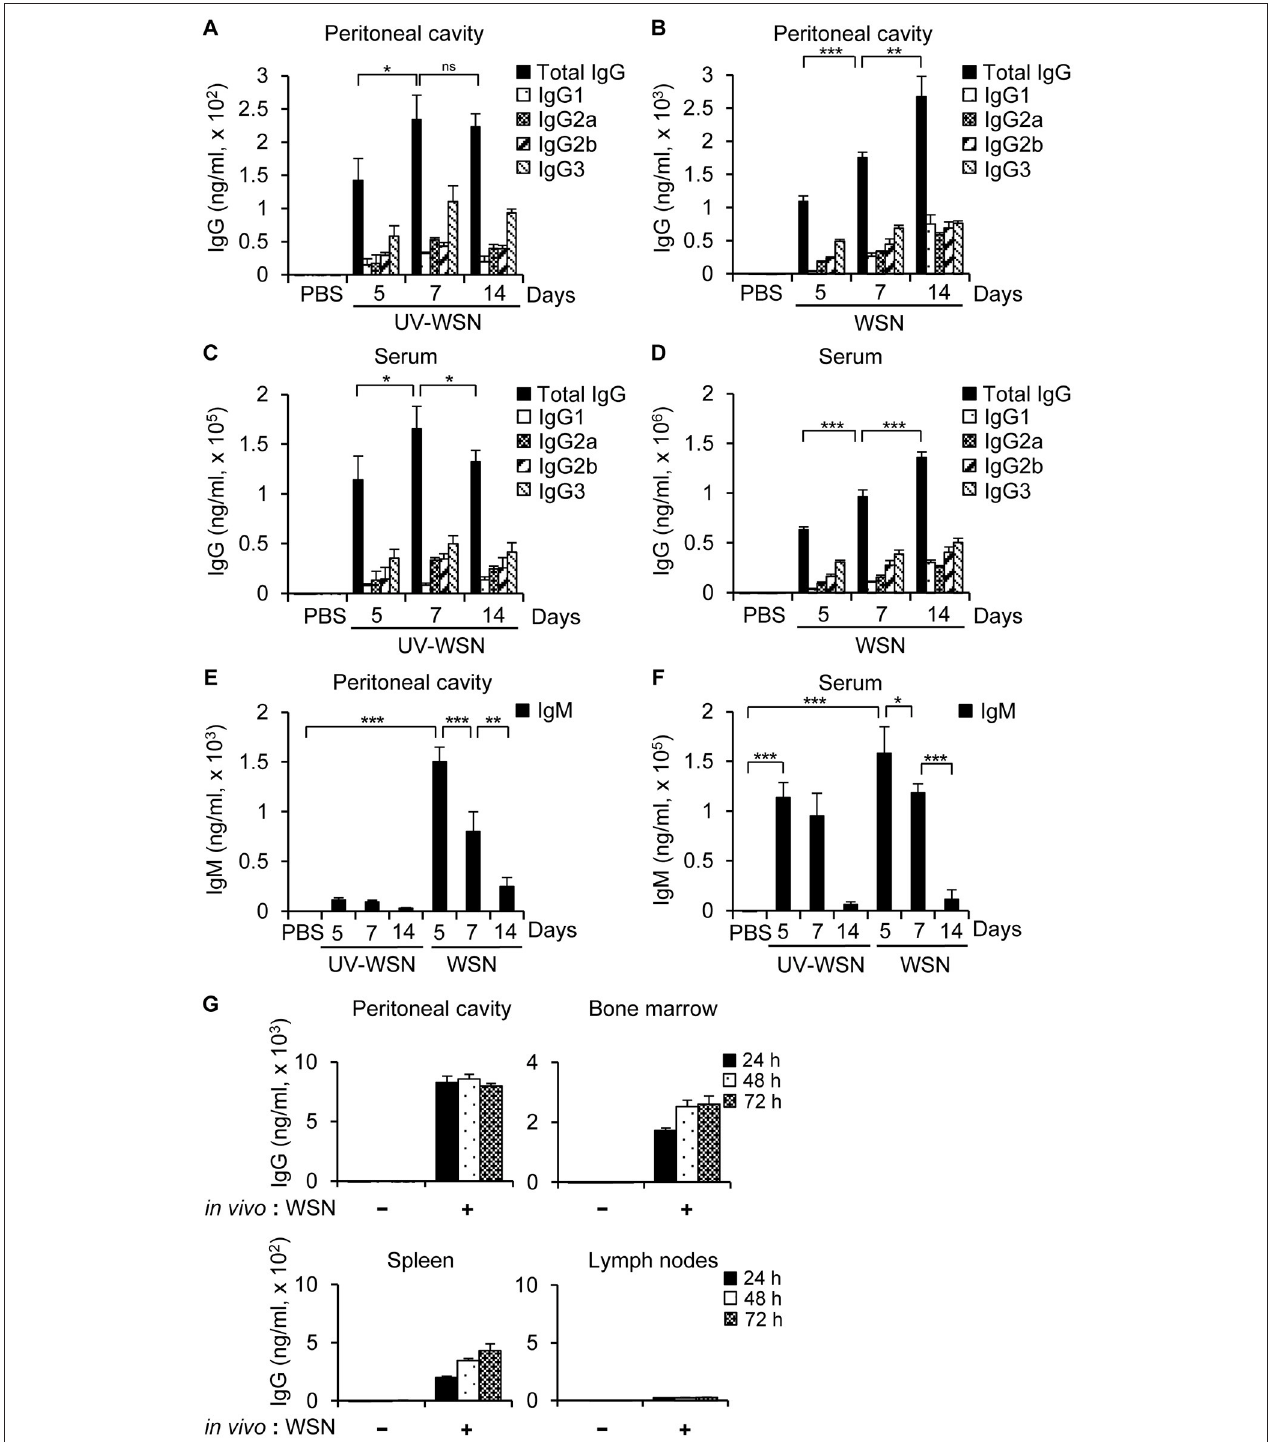
FIGURE 1 | Antibody production in BALB/c mice following intraperitoneal challenge with A/WSN/1933 virus or UV-inactivated A/WSN/1933 virus. BALB/c mice ( n = 5/group) were anesthetized at 5, 7, and 14 days after intraperitoneal challenge with 5 × 10 6 pfu of live A/WSN/1933 virus (WSN) or UV-inactivated A/WSN/1933 virus (UV-WSN), and samples of peritoneal cavity fluid and serum were collected. (A,B) The amounts of A/WSN/1933 virus-reactive IgG and IgG subclasses in theperitonealcavityfluidsfollowingUV-WSNvirus (A) andA/WSN/1933virus (B)